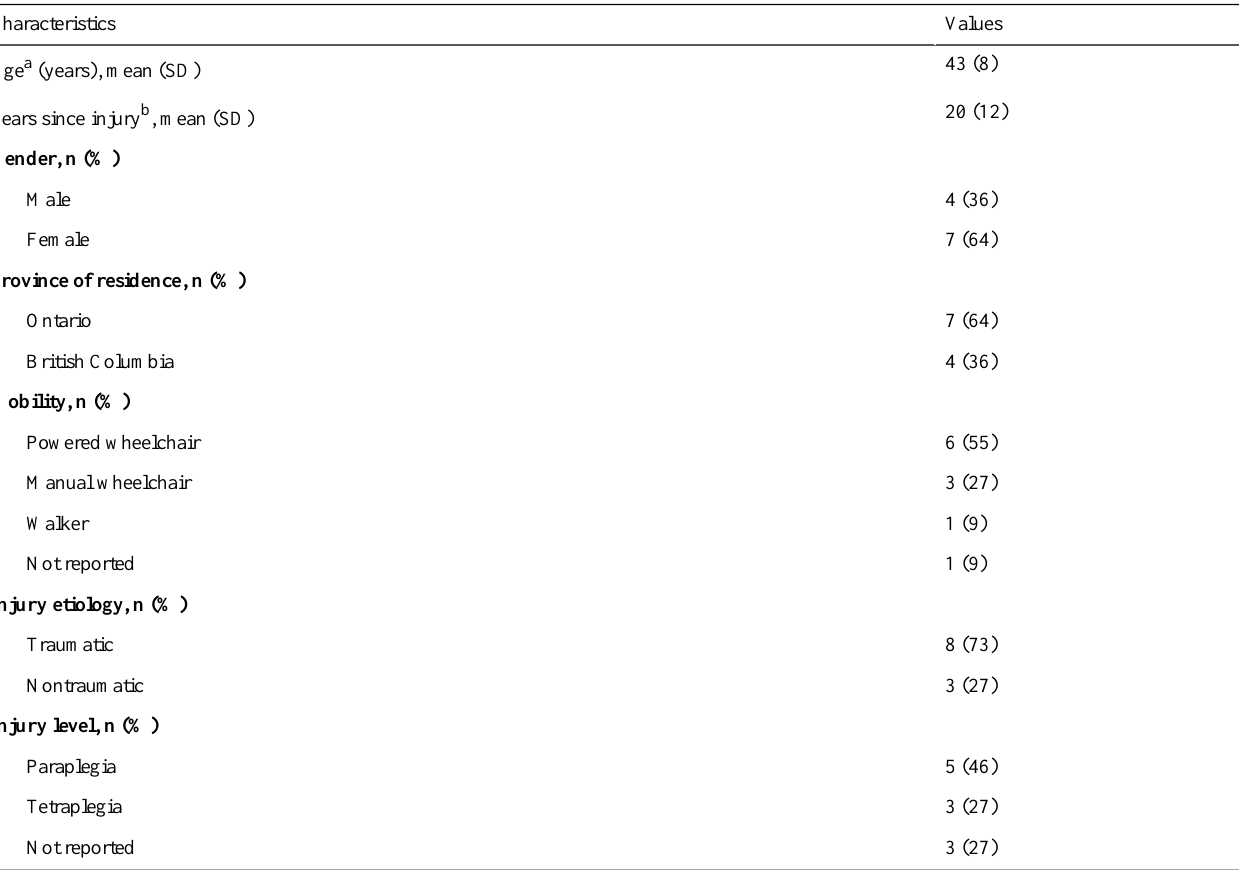
Table 1. Demographics of participants